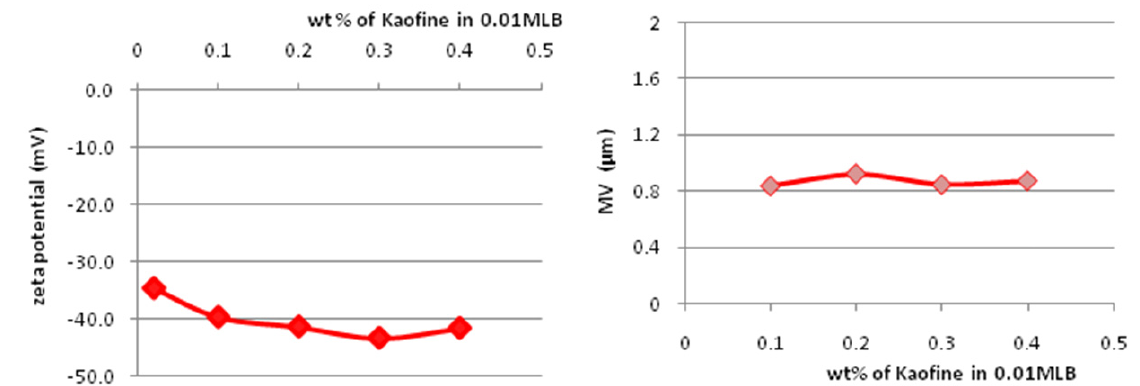
Figure 3. The effect of kaoline wt% in 0.01MLB on zeta potential and size distribution.